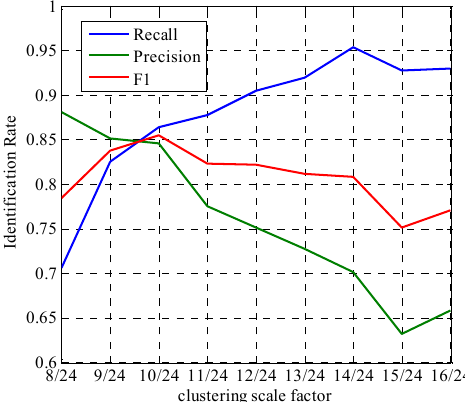
Figure 10. Identification rate with different clustering scale factors.